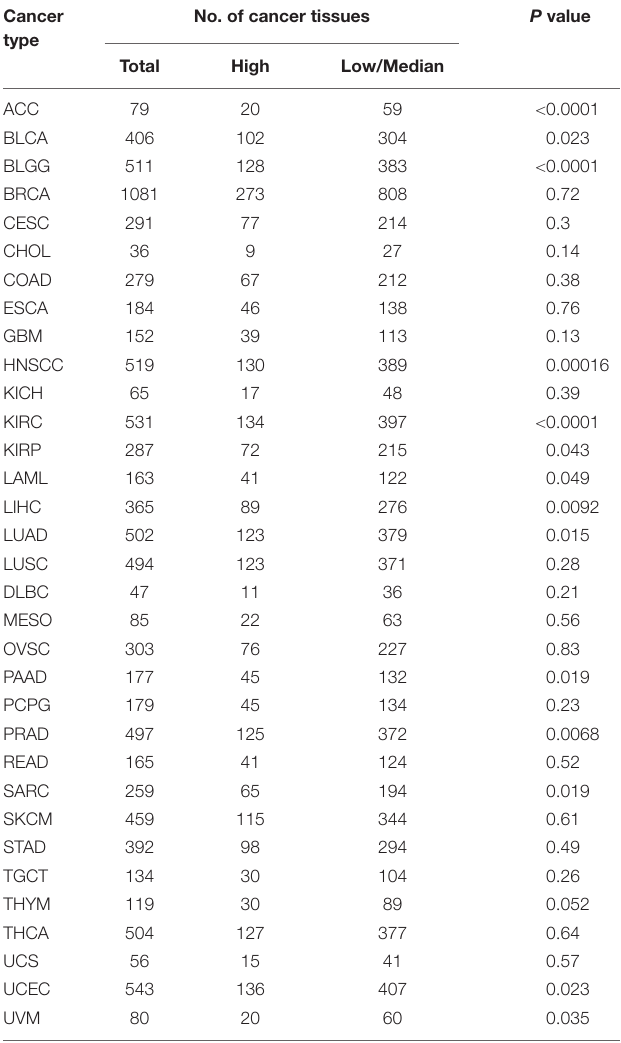
TABLE 5 | The difference of overall survival in cancer patients with high HMGA2 expression vs low/median expression. Cancer No. of cancer type